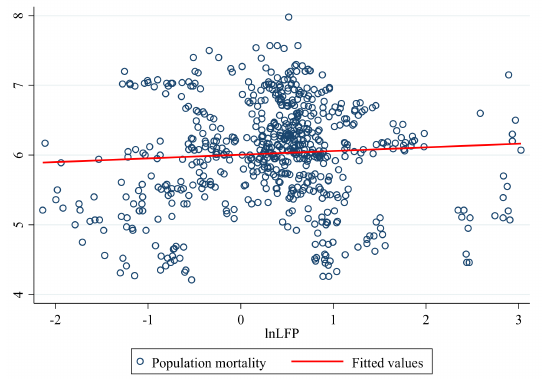
Figure 3. Scatter plot and fitted line between LFP and population mortality. (Source: China Statistical Yearbook